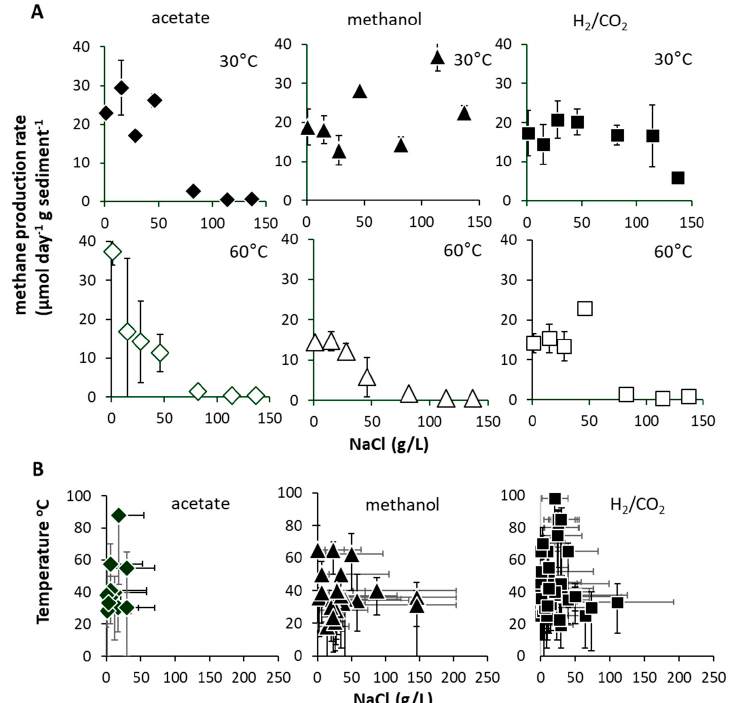
Figure 5. ( A ) Maximum methane production rates ( µ mol CH 4 g − 1 d − 1 sediment (DM) ± SE, n = 3) at 30 and 60 ◦ C (with substrate addition, acetate = white diamonds, methanol = white triangles, H 2 /CO 2 = white squares) when incubated with 1 to 137 g/L NaCl. ( B ) Summary of global cultured methanogen temperature vs. NaCl optimum and range (indicated by acetate = black diamonds, methanol = black triangles, H 2 /CO 2 = black squares). Data in ( B ) sourced from reference [5].